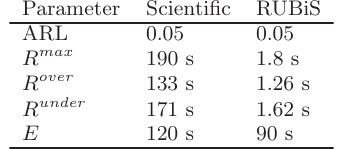
Table 2: Parameters used in the experiments Parameter Scientific